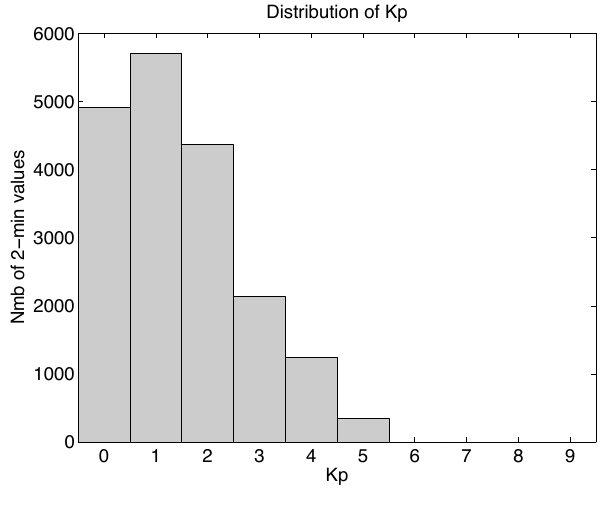
Fig. 1. Distribution of the 3-h K p index within the 2-min